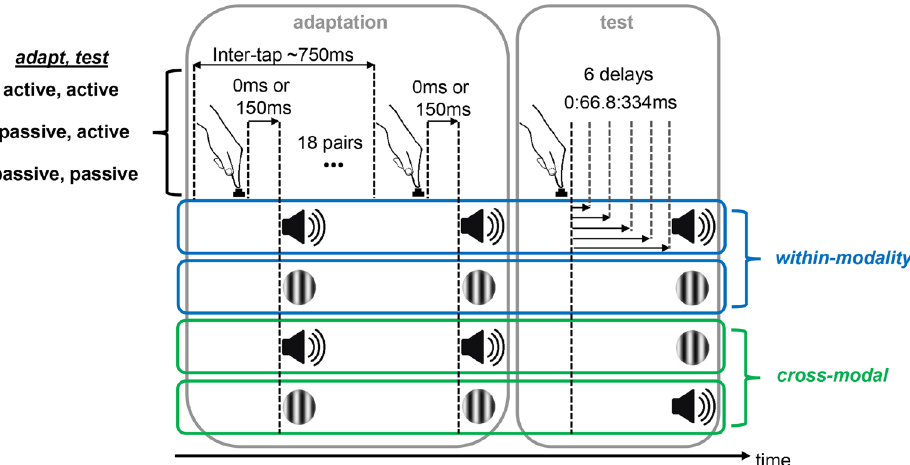
Figure 5. Schematic of the experimental conditions. In the adaptation phase, participants adapted to a systematic delay of either 0 ms or 150 ms between button press and sensory feedback. Inter-tap interval between the button press and the sensory feedback was ~ 750 ms. In the test phase, the sensory feedback was presented with variable delays (0–334 ms), and participants were asked to report whether they detected such a